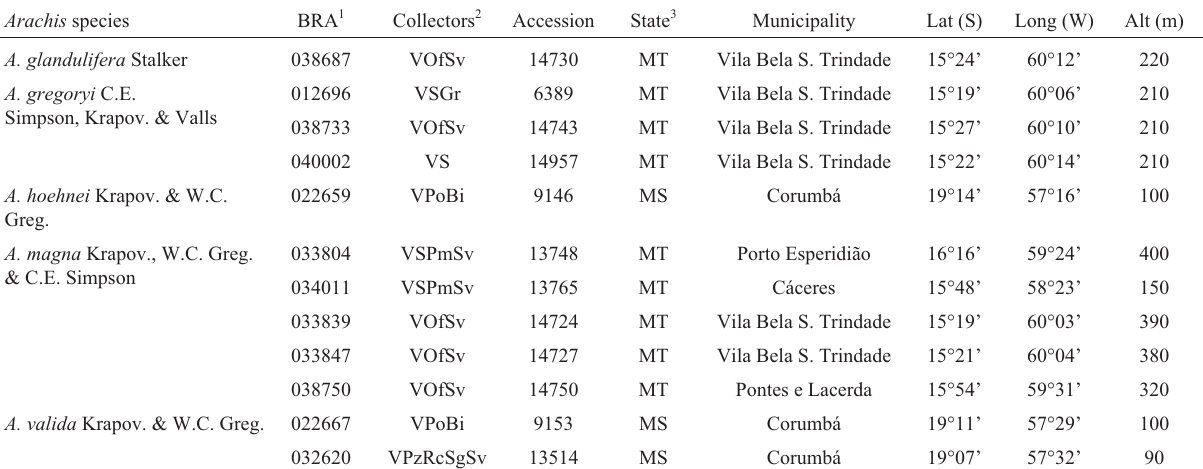
Table 1 - List of the 12 Brazilian accessions of Arachis sect. Arachis and their origins. Arachis